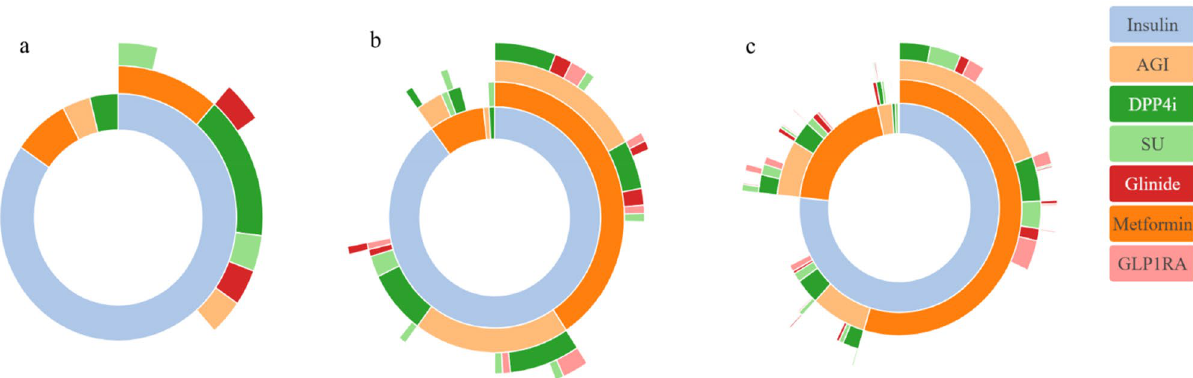
Figure 6. Combination patterns of hypoglycemic drugs in patients with different renal function. ( a ) patients with eGFR < 30 ml/min/1.73 m 2 ; ( b ) patients with eGFR 30–59 ml/min/1.73 m 2 ; ( c ) patients with eGFR ≥ 60 ml/ min/1.73 m 2 . The inner circle refers to the proportion of patients using SGLT2 inhibitor with other ONE hypoglycemic drug, such as combination of SGLT2i and insulin (the light blue part). Each part of outer circle refers to the proportion of patients using SGLT2 inhibitor with other TWO, THREE, FOUR hypoglycemic drugs, respectively. AGI, alpha-glucosidase inhibitors; DPP4i, dipeptidyl peptidase-4 inhibitors; GLP1RA, glucagon-like peptide-1 receptor agonists; SU,